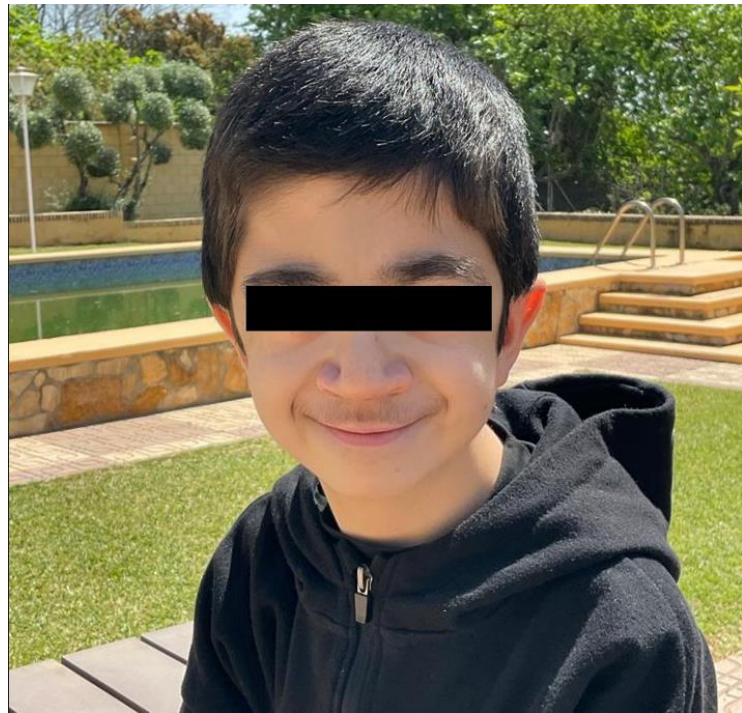
Figure 1. Current photograph of the patient.